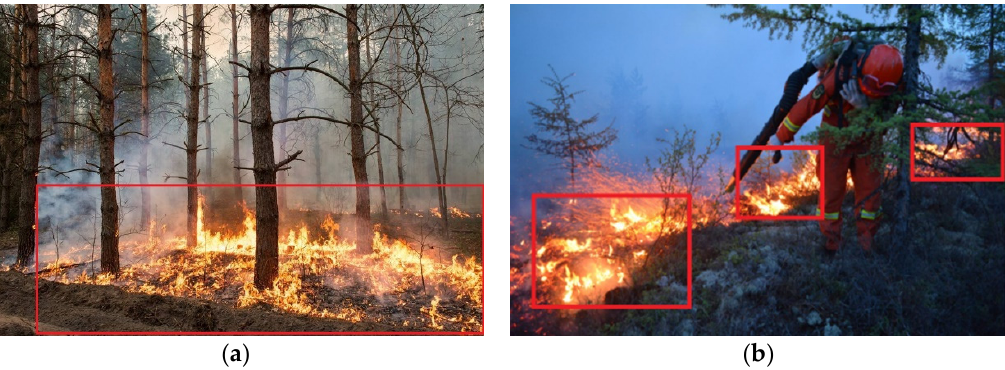
Figure 2. Annotation examples. ( a ) The large area labeling method. The flames are large area and continuous. ( b ) The small area labeling method. The flames are scattered and separated by the firefighter and trees.